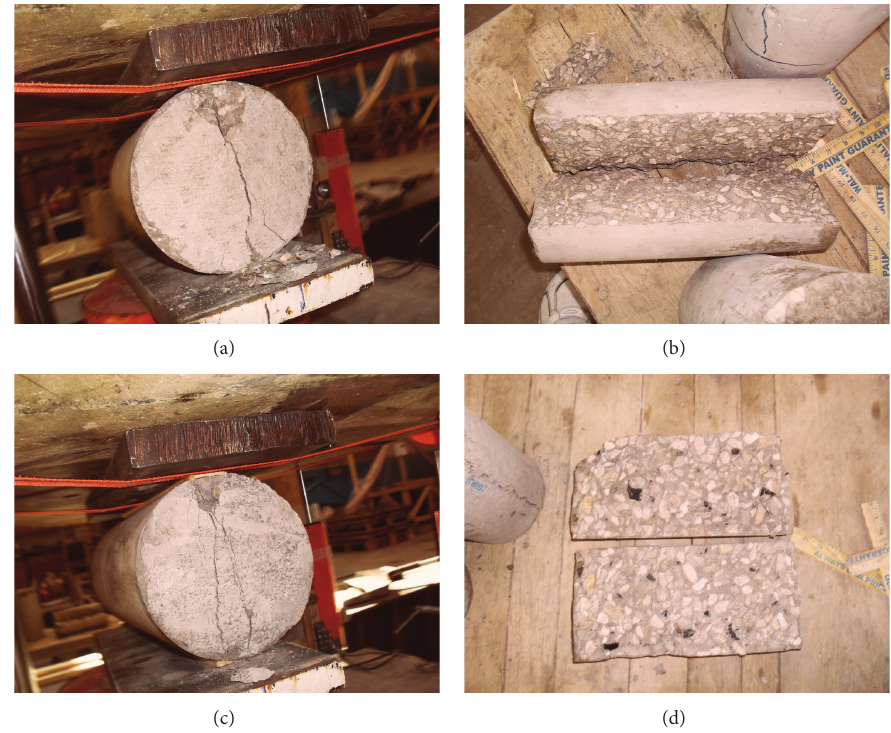
Figure 8: ((a) and (b)) Failure pattern for Control-0% TDA. Single fracture line cutting through the specimen is noted. (c) 7.5% TDA-1 󸀠󸀠